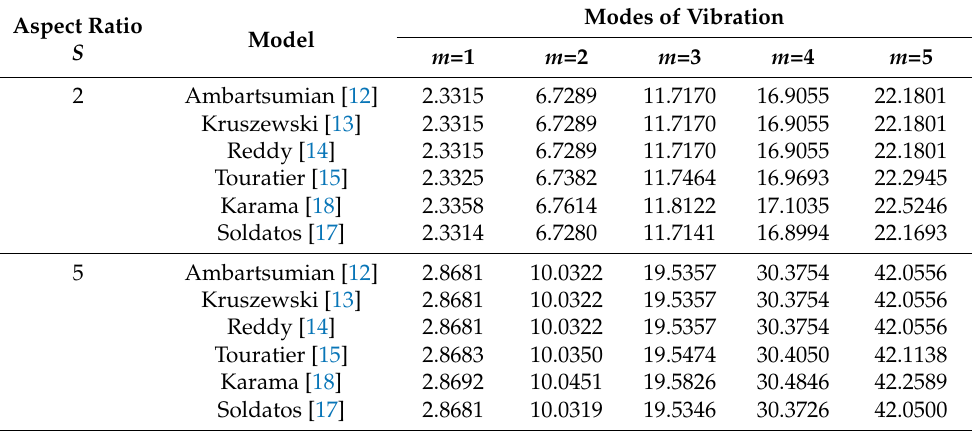
Table 6. Comparison of non-dimensional flexural frequency ω w of the piezoelectric beam for various modes of